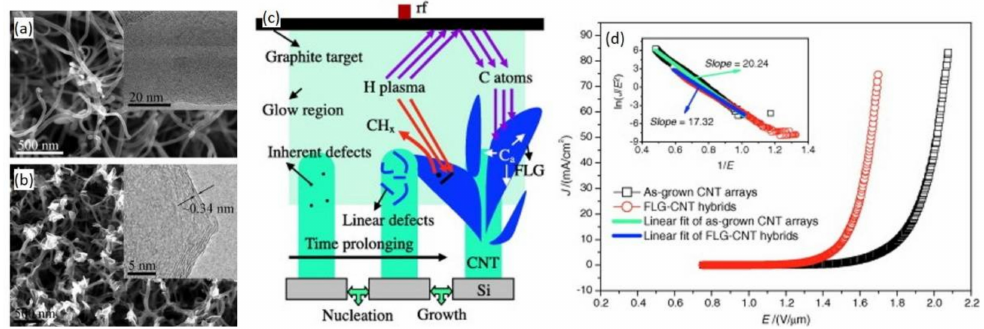
Figure 6. ( a , b ) SEM image of few-layer graphene–CNT hybrids (the inset is a TEM image showing a hybrid structure between a CNT and a FLG); ( c ) Schematic of a two-step few-layer graphene growth model: nucleation and 2D growth; ( d ) FE properties of the as-grown CNT arrays and the FLG–CNT hybrids (the corresponding F–N plots in the inset is). Image adapted with permission from [168], Copyright Elsevier,